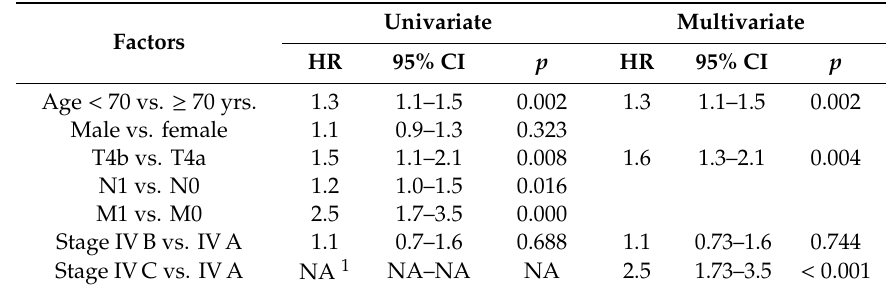
Table 5. Multivariate analysis of the factors influencing overall survival of the ATC patients according to the AJCC / UICC TNM classification, 7th edition.